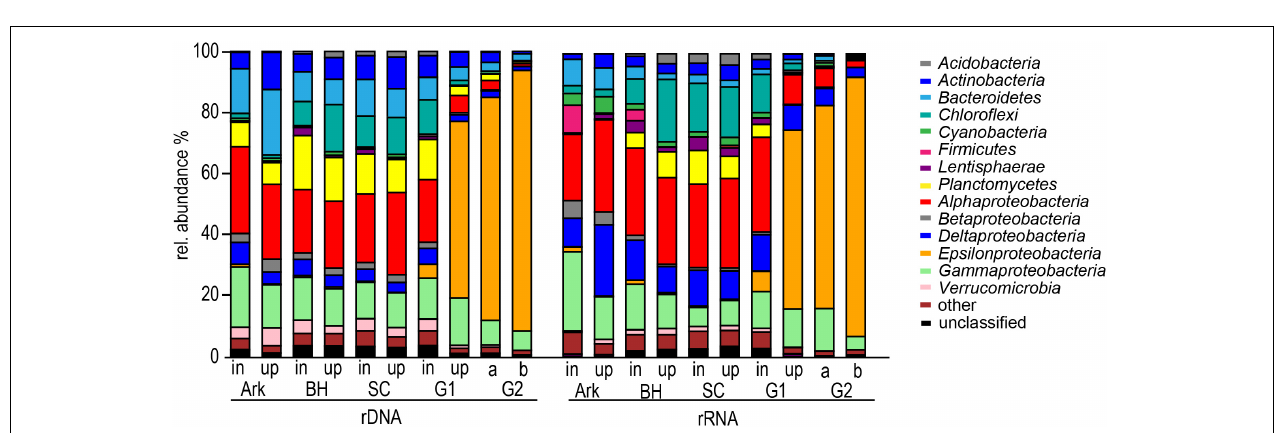
FIGURE 6 | Bacterial community composition on the phylum/class level, mean values for the stations in the Arkona Basin (Ark, n = 2), Bornholm Basin (BH, n = 10), and Slupsk Channel (SC, n = 2), and single values for stations G1 and G2. As the MBI had not reached G2, data from two depths are shown for this station (a: 126 m, b: 120